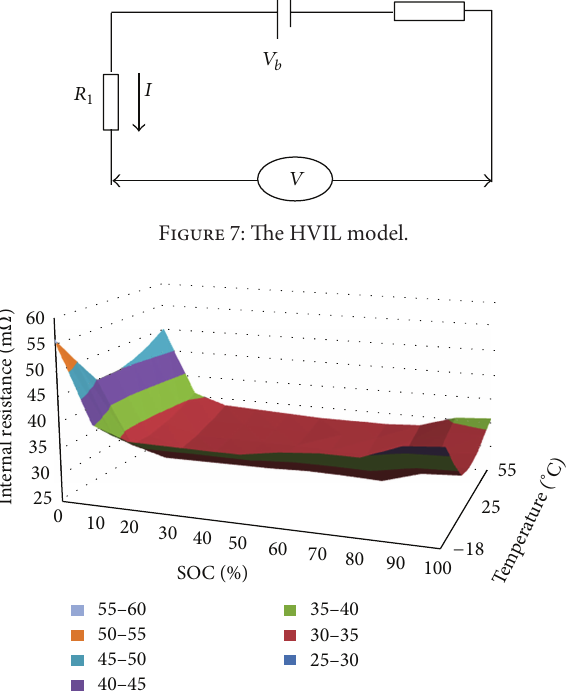
Figure 8: Battery internal resistance under different SOC and